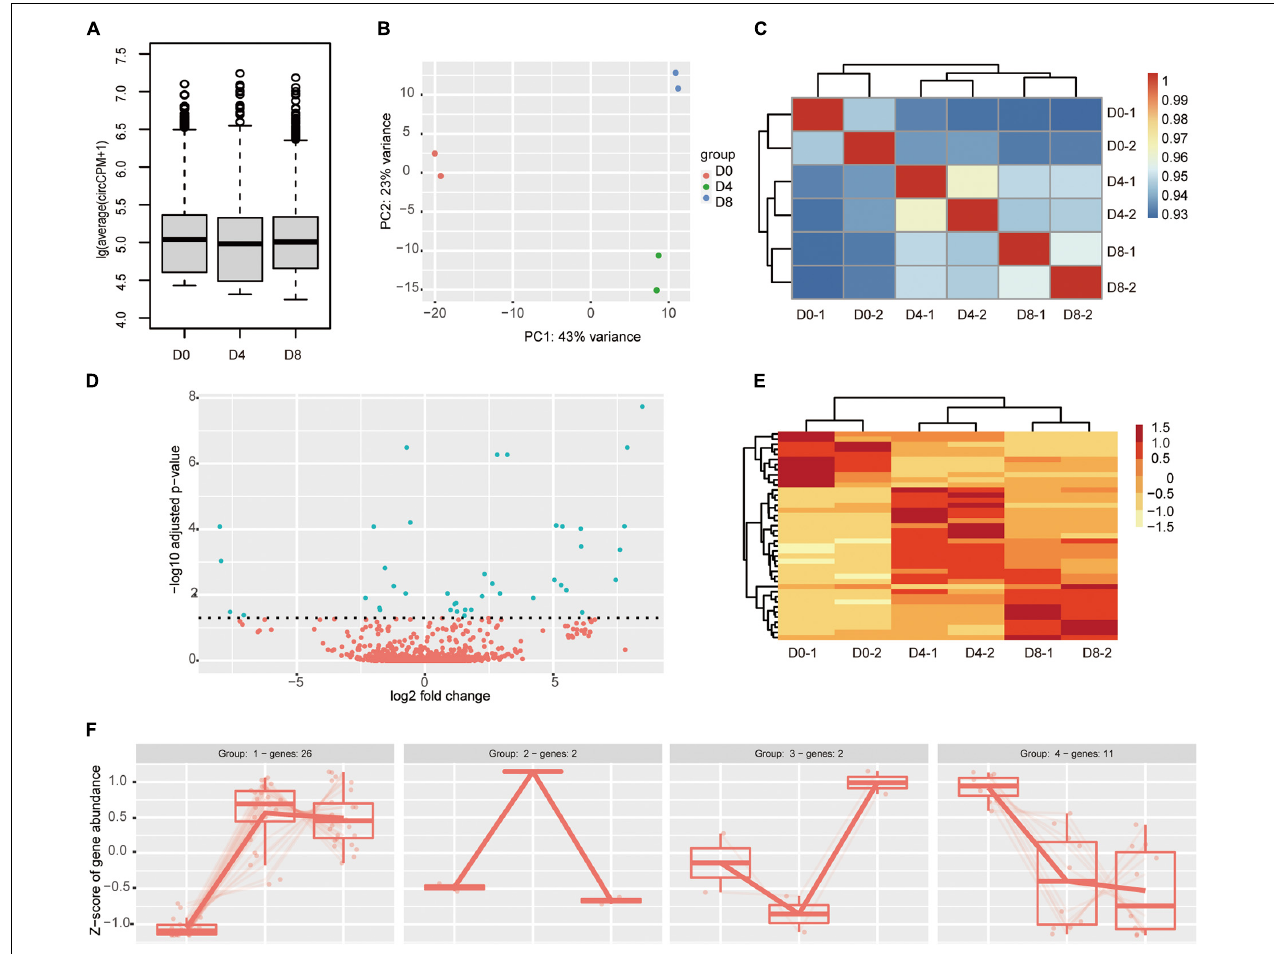
FIGURE 3 | Differential circRNAs expression during adipogenesis. (A) Relative expression abundance of circRNAs during adipogenesis (circCPM). (B) Principal component analysis (PCA) plot of RNA samples. (C) Hierarchical clustering analyses of samples correlation using DESeq2 rlog-normalized RNA-seq results. (D) Volcano plot comparing circRNAs abundance between different adipogenesis stages. The green color indicates the differentially expressed circRNAs (padj < 0.05), while the red color indicates not significant change circRNAs. (E) Heatmap showing differentially expressed circRNAs across different stages of adipogenesis. (F) Expression patterns of the differential expressed circRNAs during